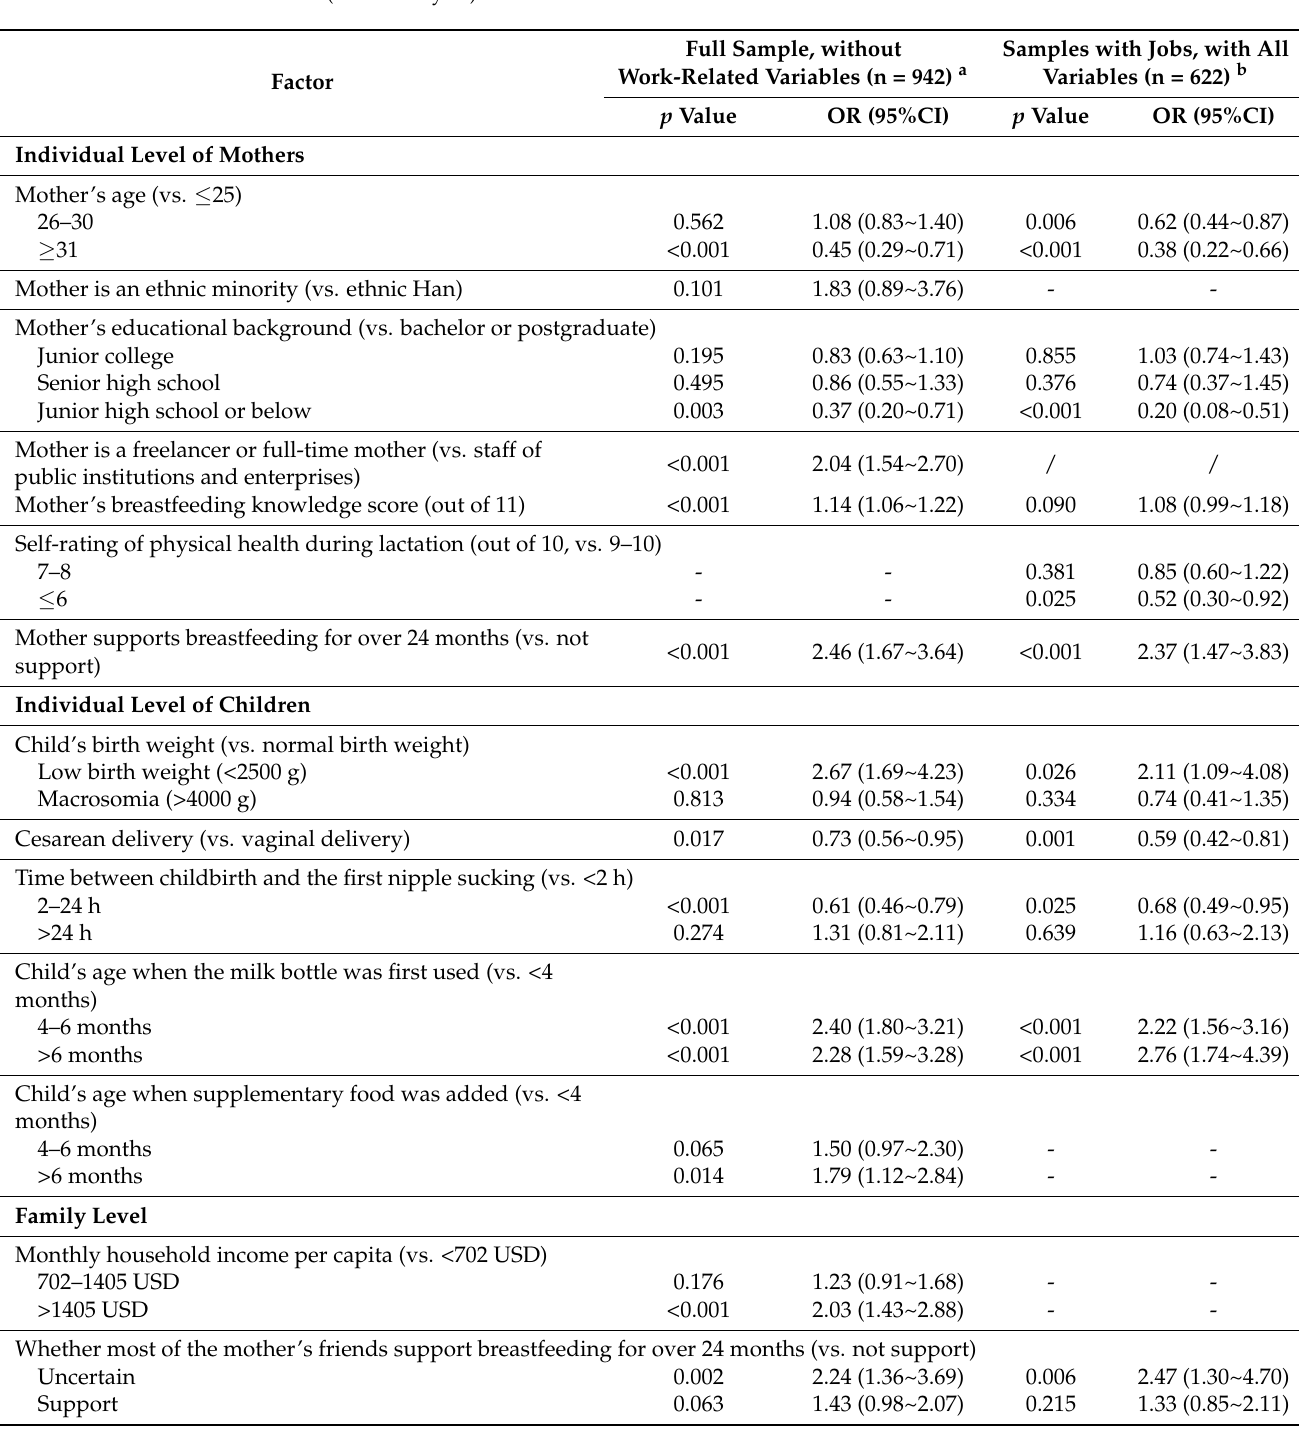
Table 2. Multivariable ordinal logistic regression of influencing factors of breastfeeding duration (main analysis). Samples with Jobs, with All Full Sample, without Variables (n = 622) Work-Related Variables (n = 942) a Factor